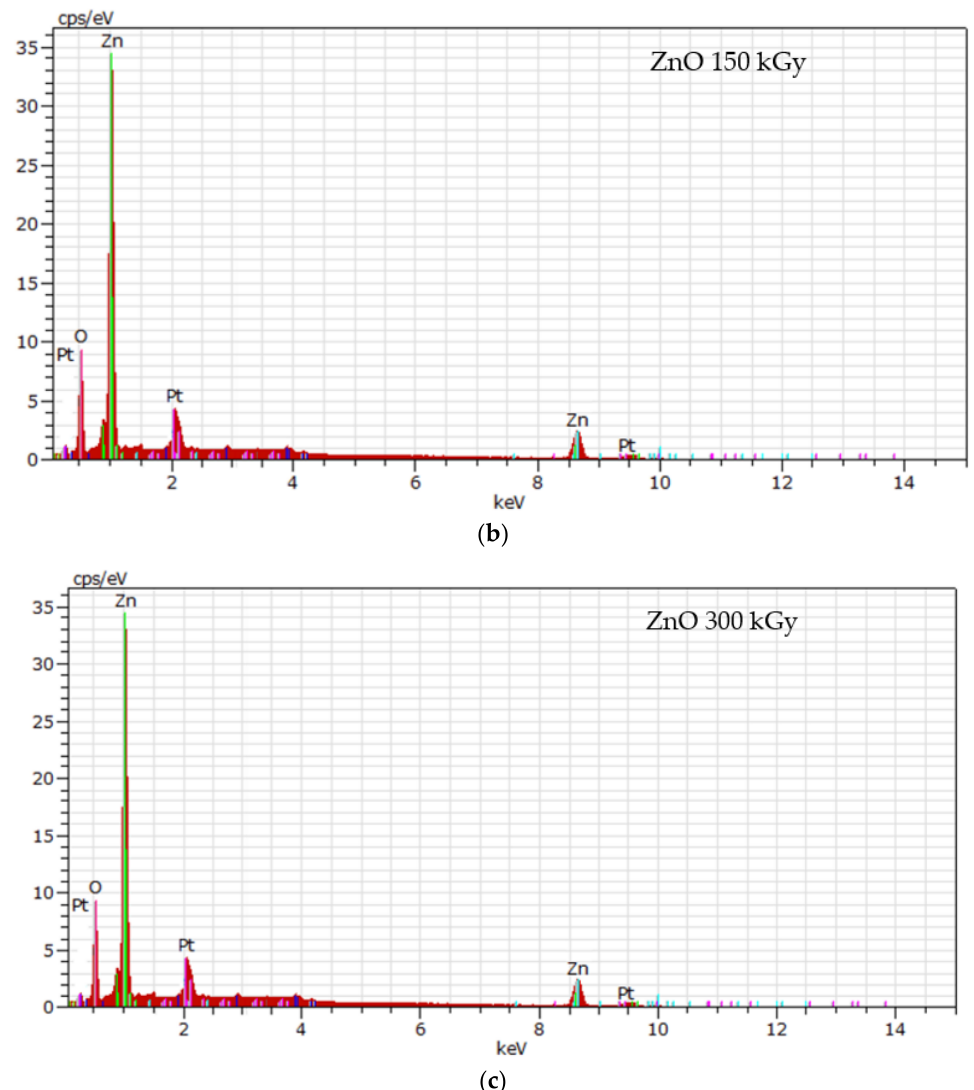
Figure 2. EDX of ( a ) ZnO pre- and post-irradiation changes ( b ) 150 kGy and ( c ) 300 kGy.